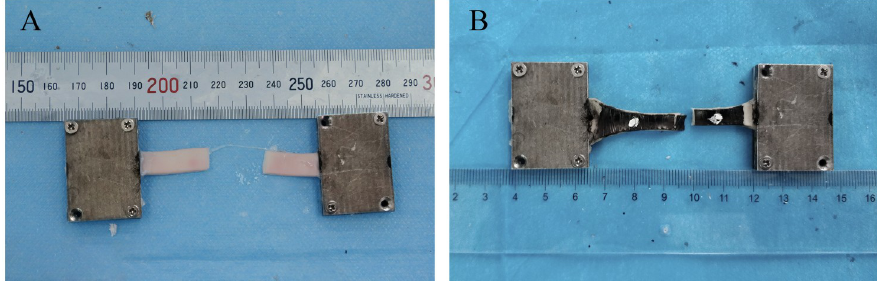
Fig 4. Failed points in the middle of specimens: (A) rectangular specimen and (B) dog-bone-shaped